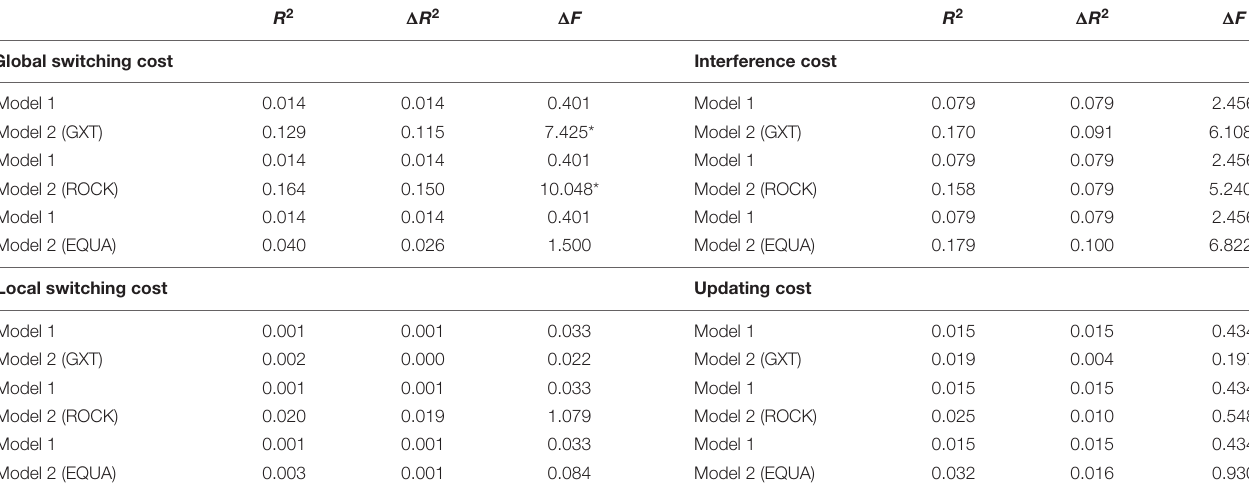
TABLE 2 | Summary of regression analyses predicting executive function performance.